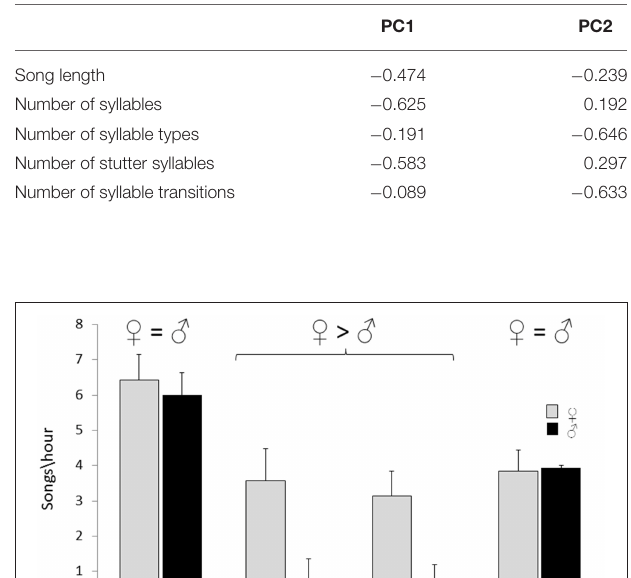
total number of syllables and stutters per song, while PC2 was of transitions per song. The principle component scores for PC1 and PC2 were then used as predictors in the Poisson regression. All analyzes were performed using the programming environment R (R Core Team, 2015). Where reported, means are presented with standard errors ( ± SE) and a significance level of α = 0.05 was used for all statistical tests.